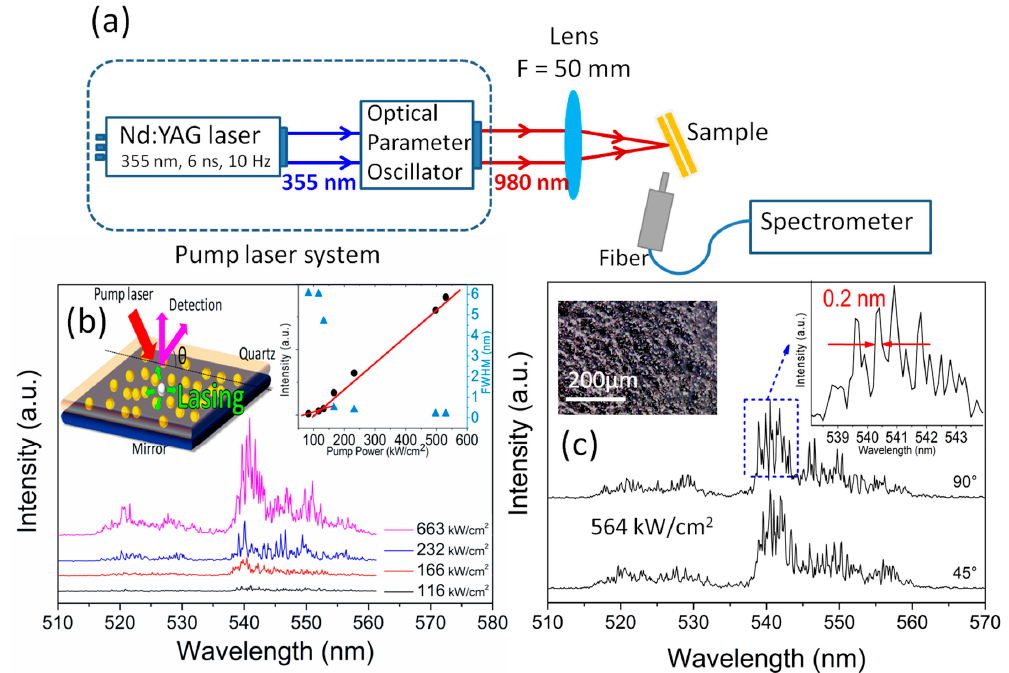
Figure 4. ( a ) Experimental setup of random laser system of NCs. ( b ) Emission spectra versus different excitation power. The left inset is the schematic of the proposed NaYF 4 :Yb,Er NCs lasers. The right insets are the corresponding input–output curve and FWHM. ( c ) Emission spectra of NaYF 4 :20%Yb,2%Er NCs film at around 540 nm wavelength recorded under 980 nm nanosecond laser excitation at different observation angles, θ . The left inset is the optical microscope image of the NaYF 4 :20%Yb,2%Er NCs film. The right inset is the FWHM of the emission spectra of NCs laser.